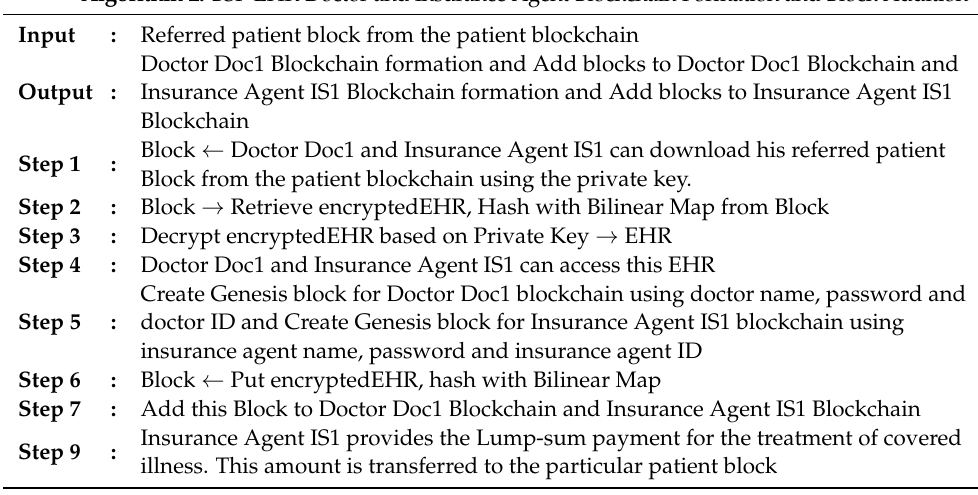
Algorithm 2. BSF-EHR Doctor and Insurance Agent Blockchain Formation and Block Addition Algorithm 2 BSF-EHR Doctor and Insurance Agent Blockchain Formation and Block